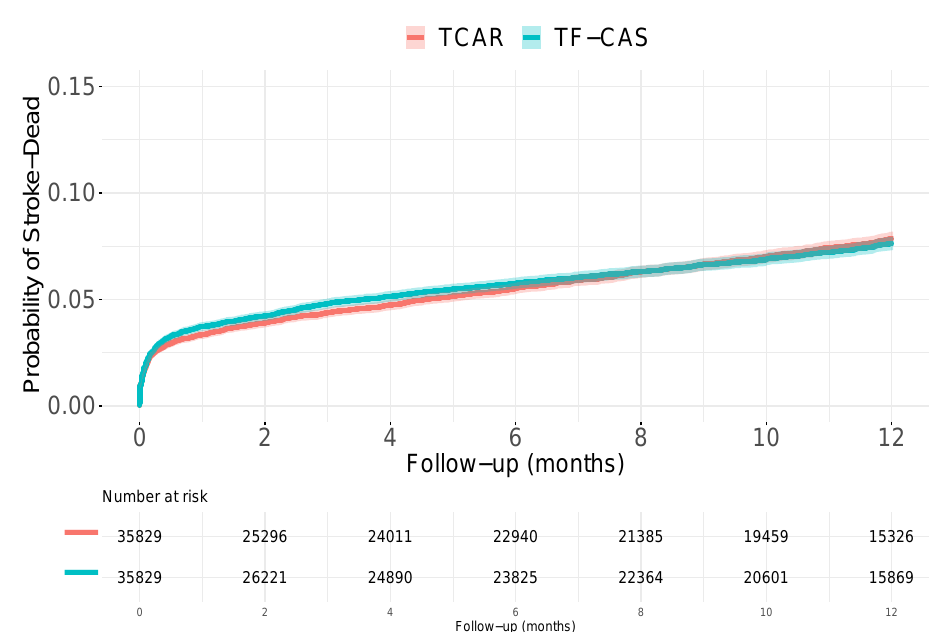
Figure 3. Kaplan–Meier estimations for the cumulative distribution functions of dying or having a stroke when the whole population undertake TF-CAS / TCAR.